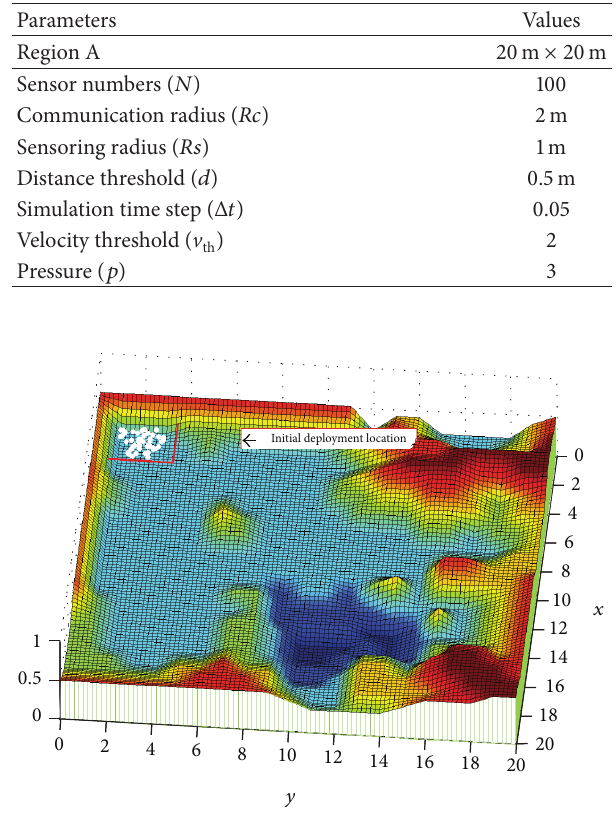
Table 1: Simulation Parameters.